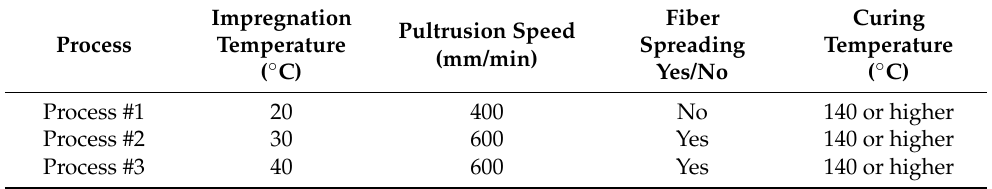
Table 3. Parameters for each process.